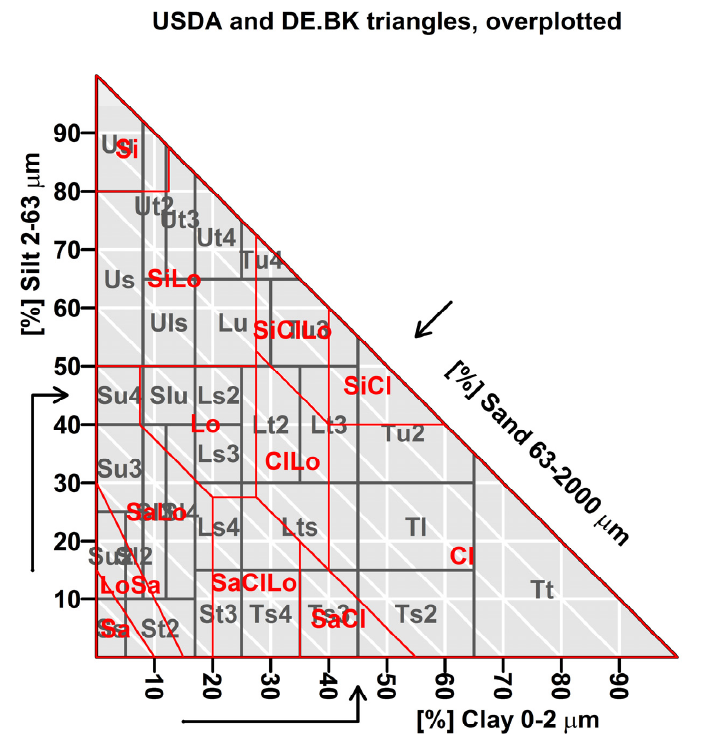
Figure 2. Over plotted soil types classified after the American system USDA (in red) and the German system (in black). The abbreviations of the soil types in the two systems are well documented in the “soiltexture” package.